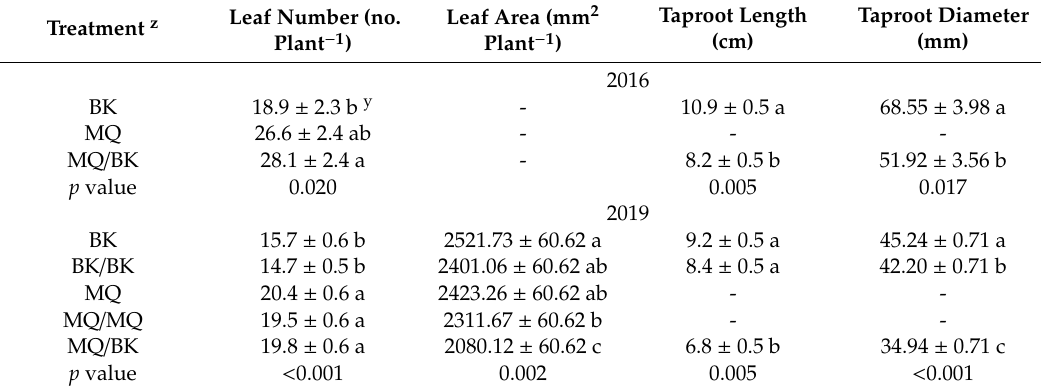
Table 2. Total leaf number and area and taproot length and diameter of grafted, self-grafted, and non-grafted pac choi and daikon radish plants at harvest in the 2016 pilot study and the 2019 experiment. Leaf Number Treatment z